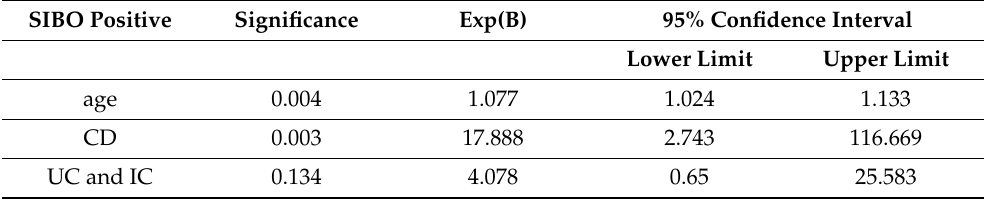
Table 6. Summary of the risk factors associated with positive